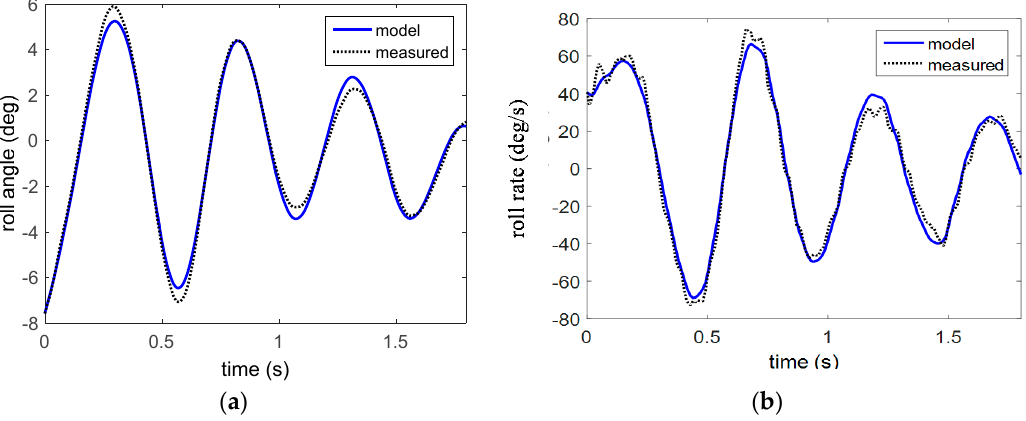
Figure 28. Modelled roll angle ( a ) and roll rate ( b ) versus the measured data for first analysis period.